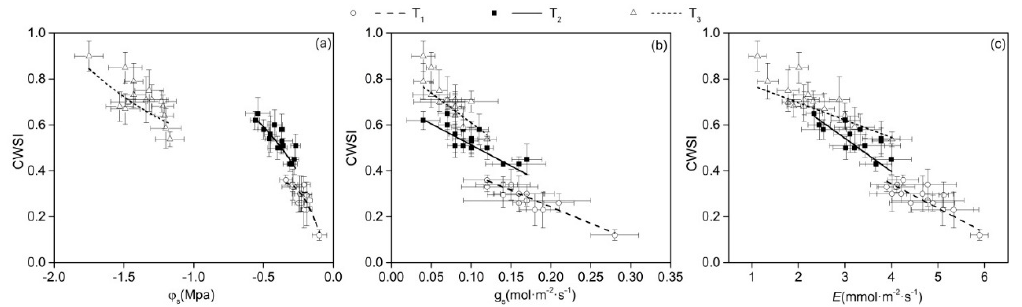
Figure 9. The relationship between CWSI and ( a ) stem water potential ( ϕ s ), ( b ) stomatal conductance ( g s ) and ( c ) leaf transpiration rate ( E ) for T 1 , T 2 and T 3 treatment. The di ff erent lines represent the fitting regression lines to the date. T 1 represents 100% M, T 2 represents 80% M, T 3 represents 60%. Table 7. Regression coe ffi cient and accuracy evaluation of fitting equation between CWSI and plant water status index.